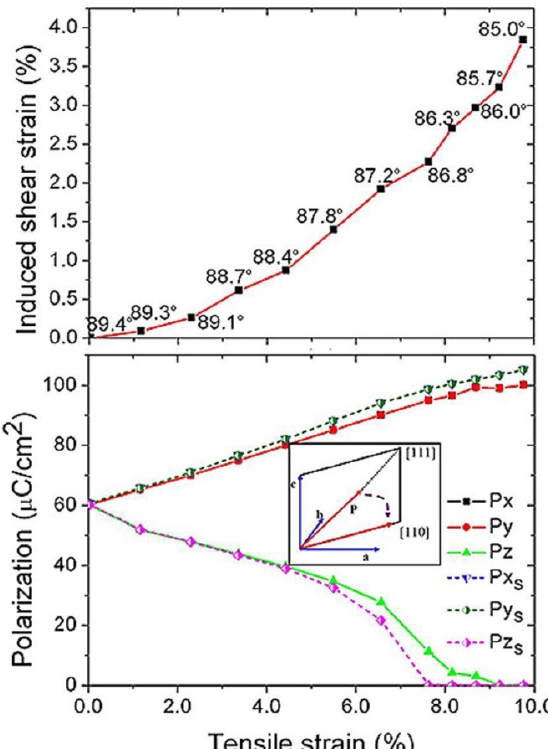
polarization under tensile strain. (Reprinted with permission from [65]. Copyright 2014 Macmillan Publishers